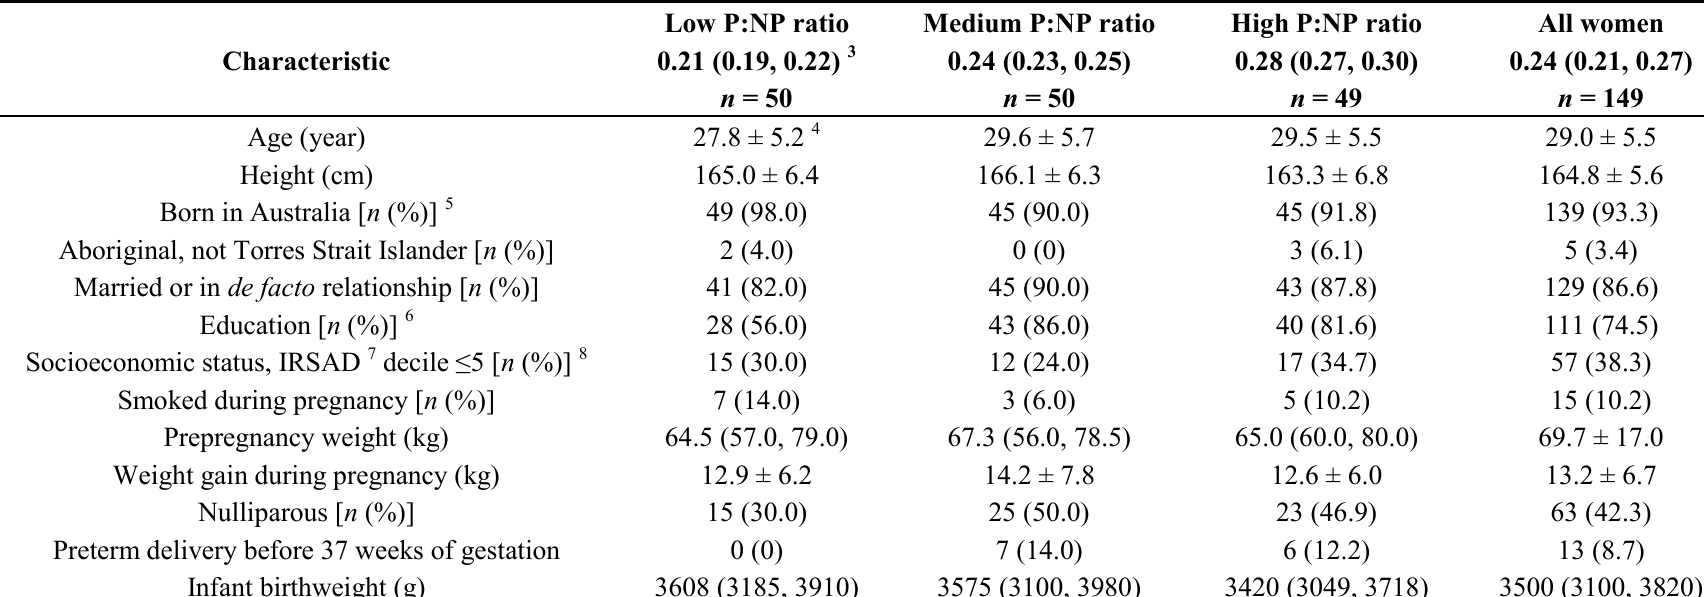
Table 1. Maternal characteristics and pregnancy outcomes for the participants in the WATCH study with plausible dietary data, by tertile of the protein to non-protein ratio ( n = 149) 1,2